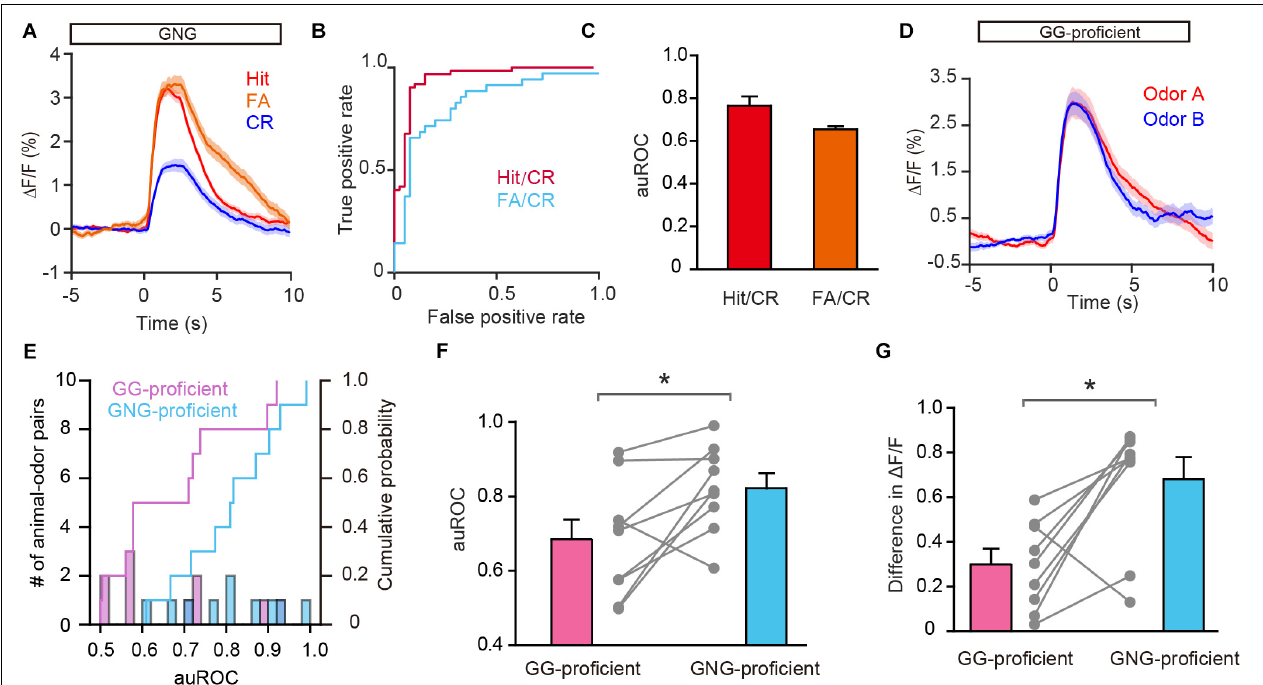
FIGURE 6 | Odor responses in GCs reflect odor value as opposed to odorant identity. (A) Averaged traces for Hit, FA, and CR trials during the go/no go (GNG) task across all animal-odor pairs. (B) ROC analysis for Hit/CR and FA/CR from an individual mouse. (C) The auROCs for Hit/CR trials and FA/CR trials across all mice performing the go/no go task. (D) Averaged traces of odor responses during the go/go (GG) task ( n = 9 animal-odor pairs from eight mice), odor A and odor B represent the rewarded odors delivered during the go/go task. (E) Histograms and cumulative probability of auROCs in the proficient stage for the go/go task and the go/no go task. (F,G) The auROCs (F) and difference in (cid:49) F/F (G) in the proficient stage for the go/go task and the go/no go task. [ F: paired t -test, t ( 9 ) = 3.01, P = 0.0146; G: Wilcoxon’s sign rank test, W = -37.0, P = 0.0273]. * P <